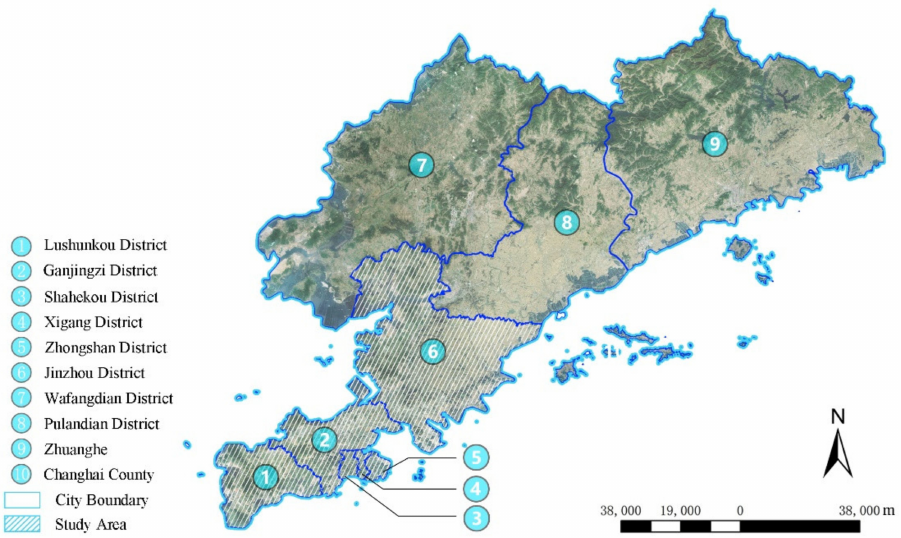
Figure 1. Research areas in Dalian of this